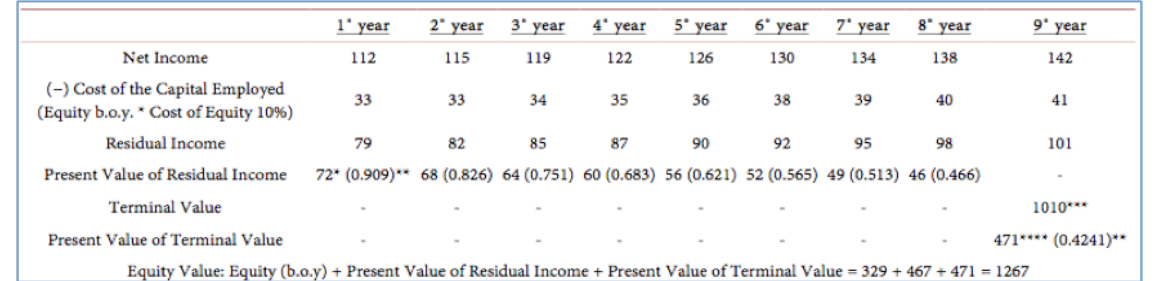
Table 2: Calculation of Equity Value using